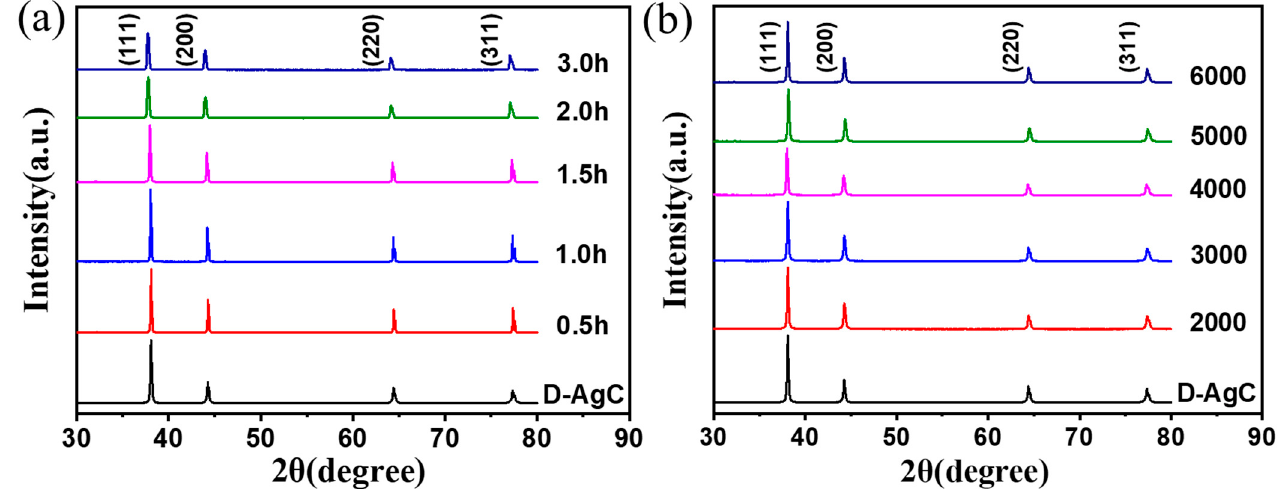
Figure 4. XRD patterns of the AgC coatings after ( a ) different annealing durations and ( b ) different laser scanning speeds.